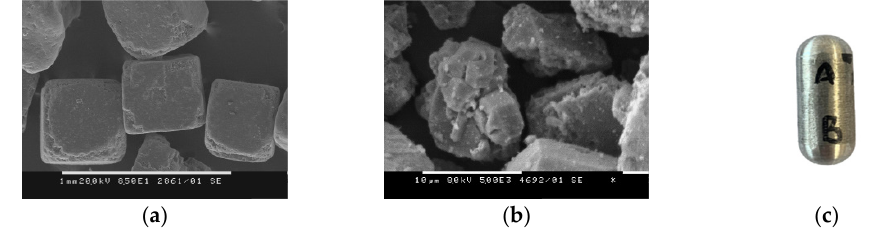
Table 3. EN-31 steel, wt%.